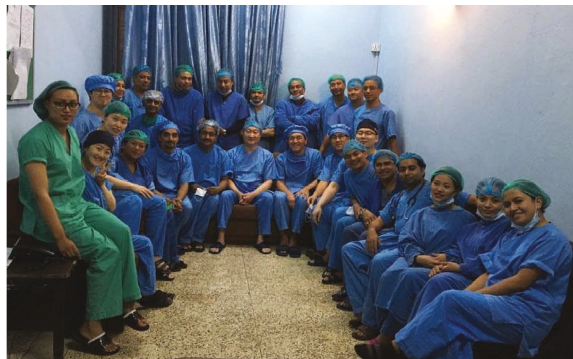
Figure 1: Group photo of the South Korean team and Nepalese team at SDNTC, Nepal, which was taken after the first liver